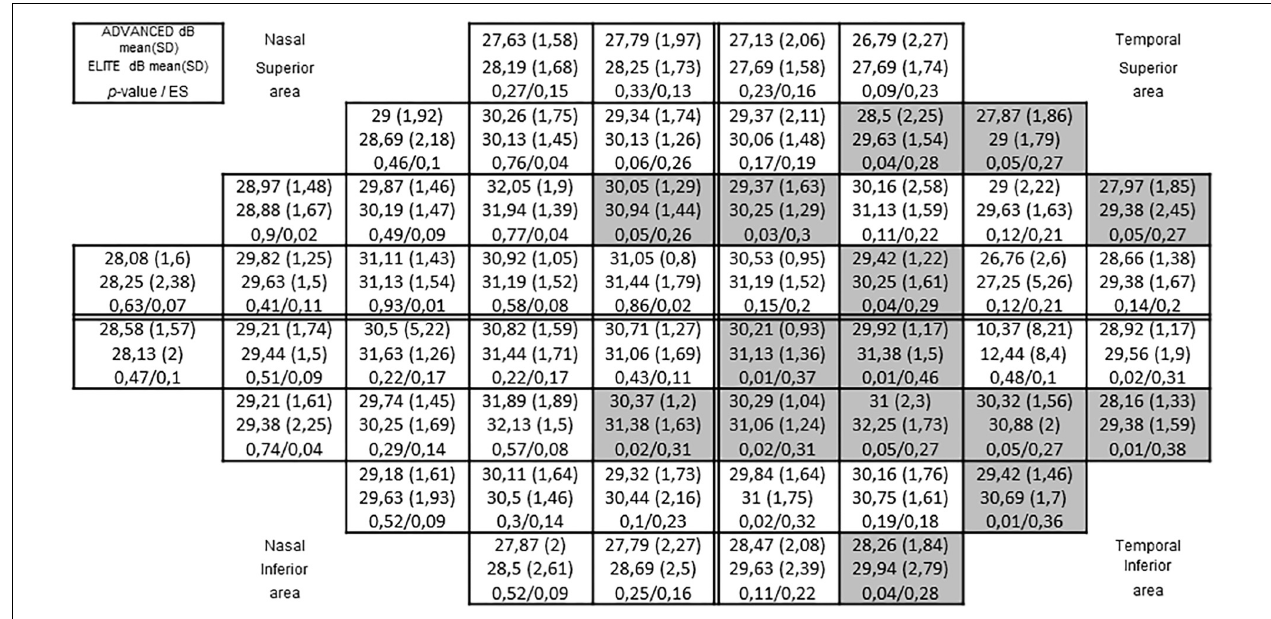
FIGURE 2 | Heidelberg edge perimeter (HEP) Visual field results between advanced and elite groups. The complete sector shaded cells represent significant differences ( p < 0.05).